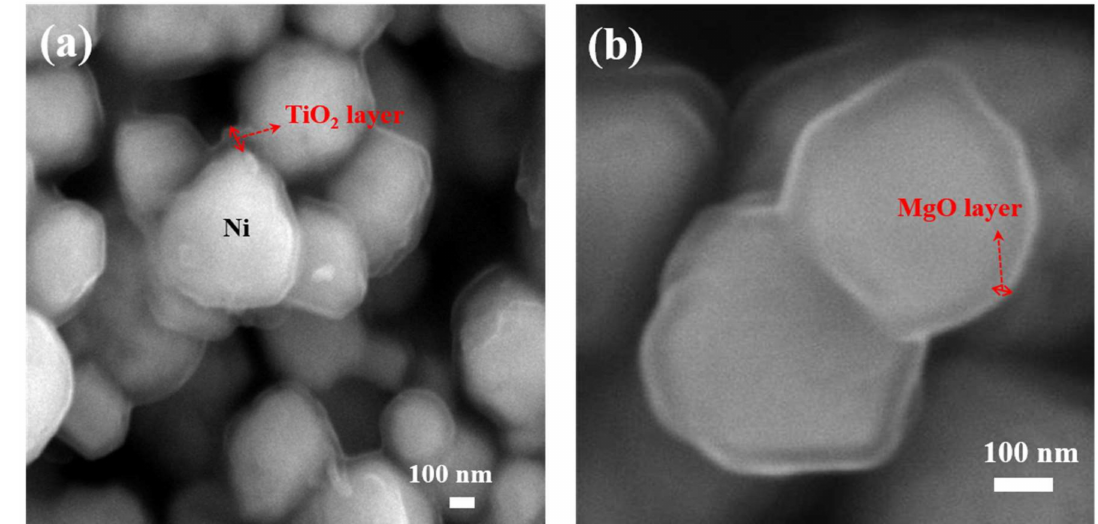
Figure 2. Transmission electron microscopy (TEM) images of ( a ) TiO 2 /Ni particles and ( b ) MgO/Ni particles prepared by applying 500 and 200 cycles of ALD, respectively. Edited from Reference